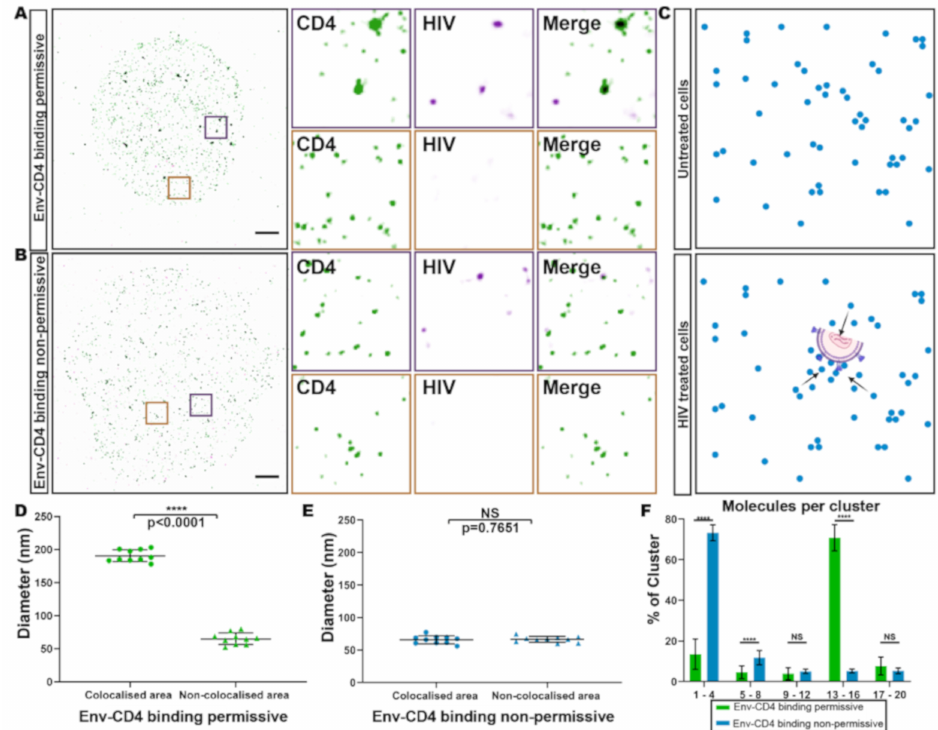
Figure 3. Analysis of HIV-bound CD4 clusters. ( A , B ) Representative TIRF-STORM images, and selected magnified regions (insets) of cell-surface CD4 (green) and HIV p24 (magenta). Scale bar = 2 µ m. ( C ) Schematic of cell-surface CD4 molecules (blue) in untreated cells ( upper panel ) and HIV treated (or bound) cells ( lower panel ). ( D , E ) Quantification of CD4 cluster diameters in the absence ( D ) or presence ( E ) of Q4120. Each dot represents the average CD4 cluster diameter on one cell. 10 cells were measured per condition, bars indicate mean ± SD. The data are representative of at least three independent experiments. ( F ) Molecule counting of colocalised areas in the absence (Env-CD4 binding permissive) or presence of Q4120 (Env-CD4 binding non-permissive). Bars indicate mean ± SD. **** p <